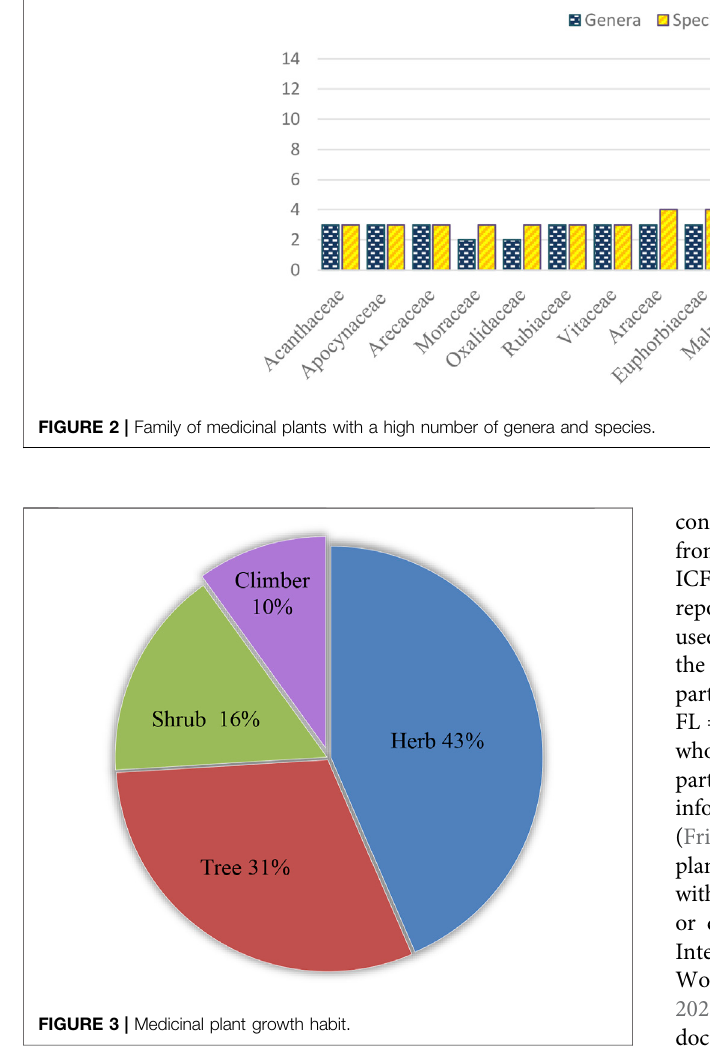
FIGURE 3 | Medicinal plant growth